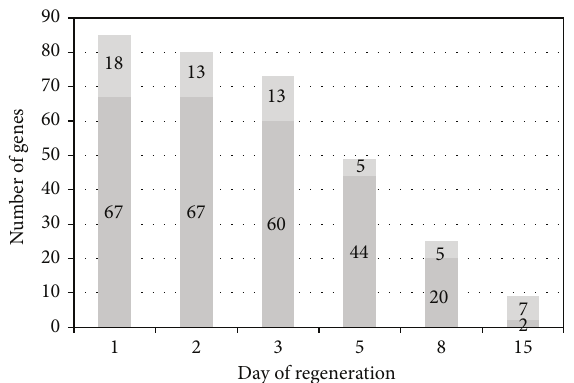
Figure 2: Affymetrix Rat Gene 1.1 ST Array. Number of genes involved in cellular proliferation, which were found to be up- /downregulated during rat adrenal regeneration ( 𝑃 < 0.05 , fold > 2). Dark grey color—increased of expression, light